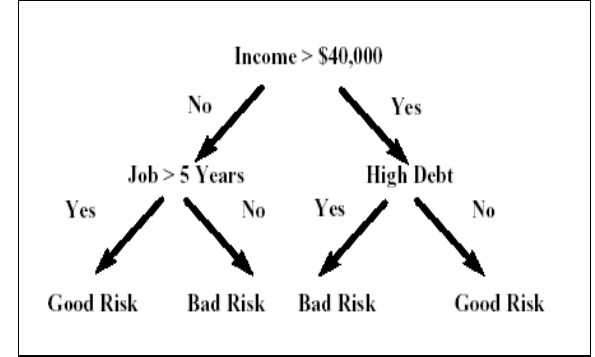
[Figure 10: Decision Tree